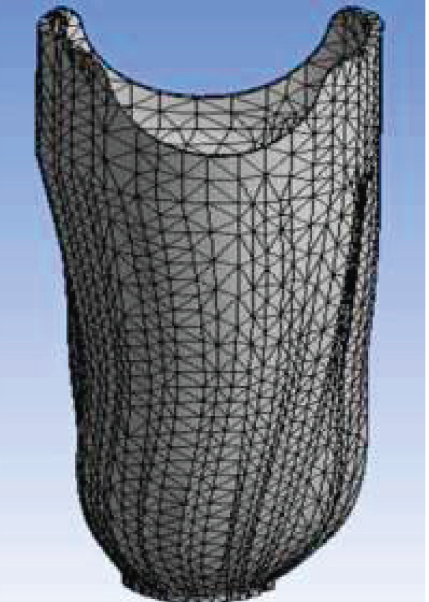
Figure 2: Prosthetic socket mesh design